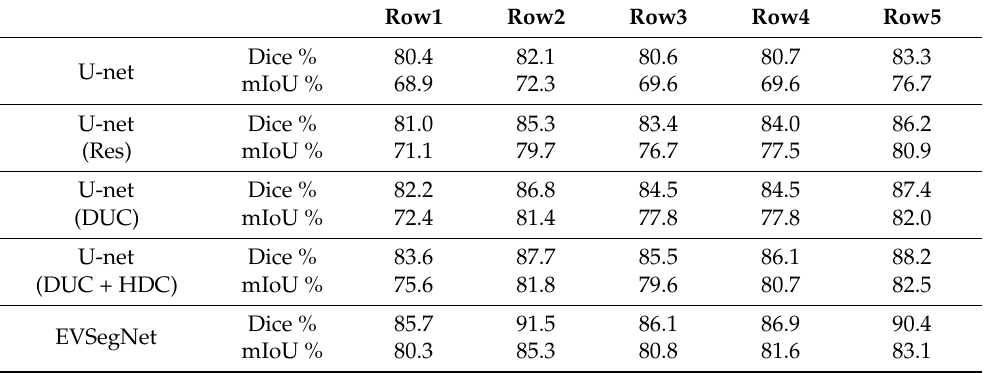
Table 2. Evaluation Results of the Visualization Examples with Different Backbones (mean (std)). Row1 Row2 Row3 Row4